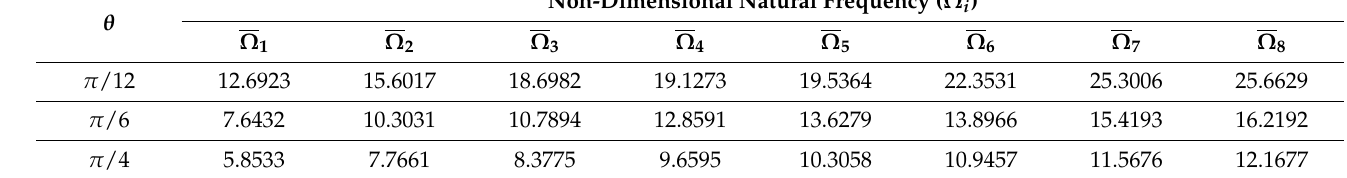
Table 4. The first eight natural frequency parameters